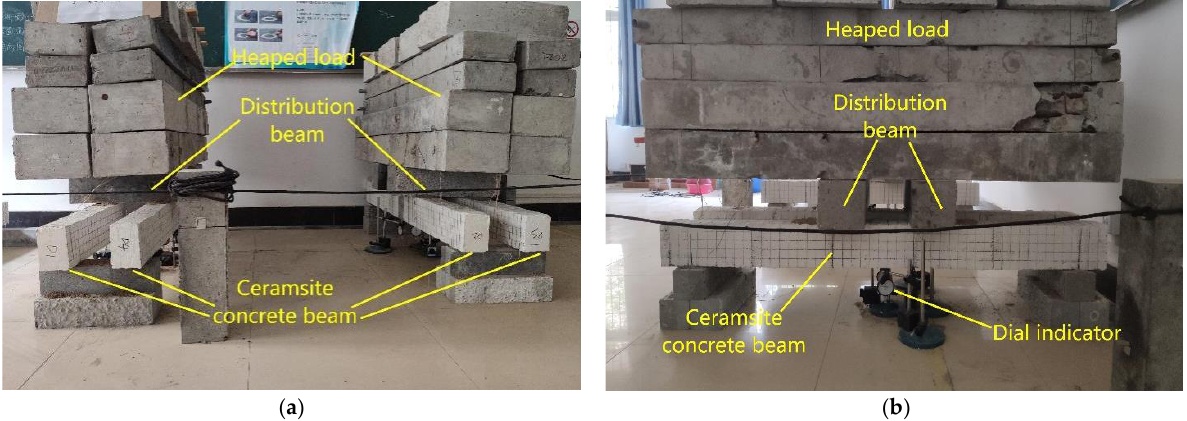
Figure 3. Snapshots of loading. ( a ) Front view. ( b ) Side view.